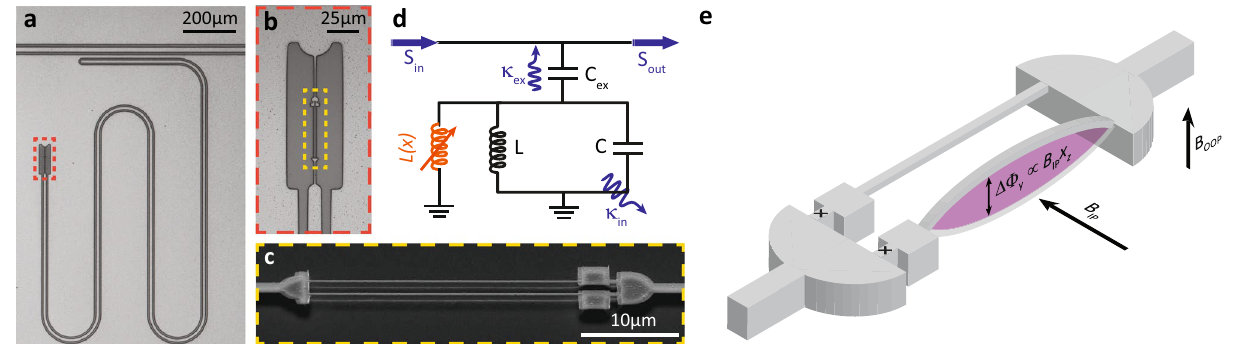
Figure 1. Device layout and schematic. ( a ) optical micrograph image of the (cid:31) / 4 coplanar-waveguide resonator coupled to a feedline (top) and short-circuited to ground via a flux-dependent inductance formed by a dc-SQUID (orange box). ( b ) Magnified view of the dc-SQUID with freely suspended strings. ( c ) Tilted scanning electron micrograph image of a suspended SQUID structure similar to the one used in this work. Note that the actual device features nanostrings of 20 µ m length. ( d ) Equivalent circuit representation of the device. The CPW resonator is described by means of an effective capacitance C and inductance L , forming an LC-oscillator. Additionally, the circuit contains a dynamic inductance (orange), whose magnitude depends on the time-varying displacement x ( t ) of the mechanical element. ( e ) Illustration of the SQUID with incorporated nanostrings and relevant magnetic field directions. The shading illustrates how the motion of the